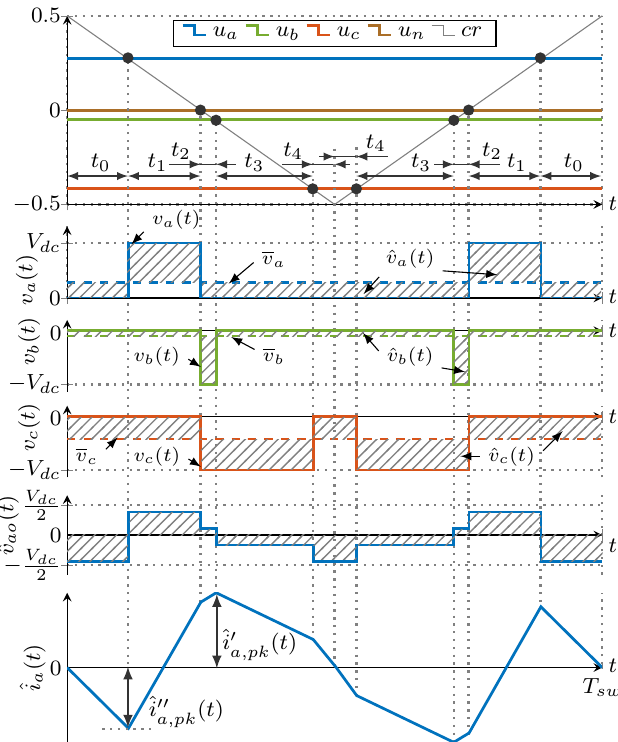
Figure 2. Generic case of the sinusoidal pulse-width modulation (SPWM) strategy (top), pole voltages of the three-phase inverter and high-frequency voltage component ˆ v ao (middle), and phase a current ripple waveform in one switching period (bottom).